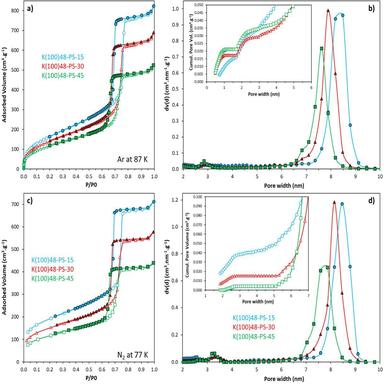
Ar at 186 C and N2 at 196 C physisorption isotherms (a, c) and corresponding NLDFT desorption pore size distributions (b, d) of K(100)48-PS composite materials. Magnified NLDFT cumulative pore volume curves, calculated from the adsorption branches, are presented in insets.